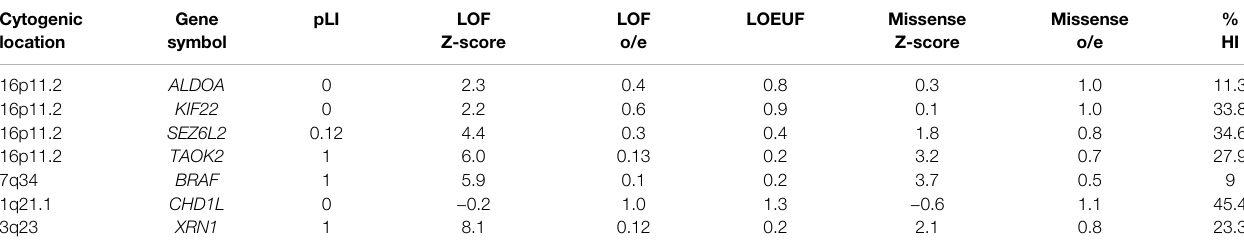
TABLE 3 | Predicted constrained metrics for the genes involved in deletions. Cytogenic